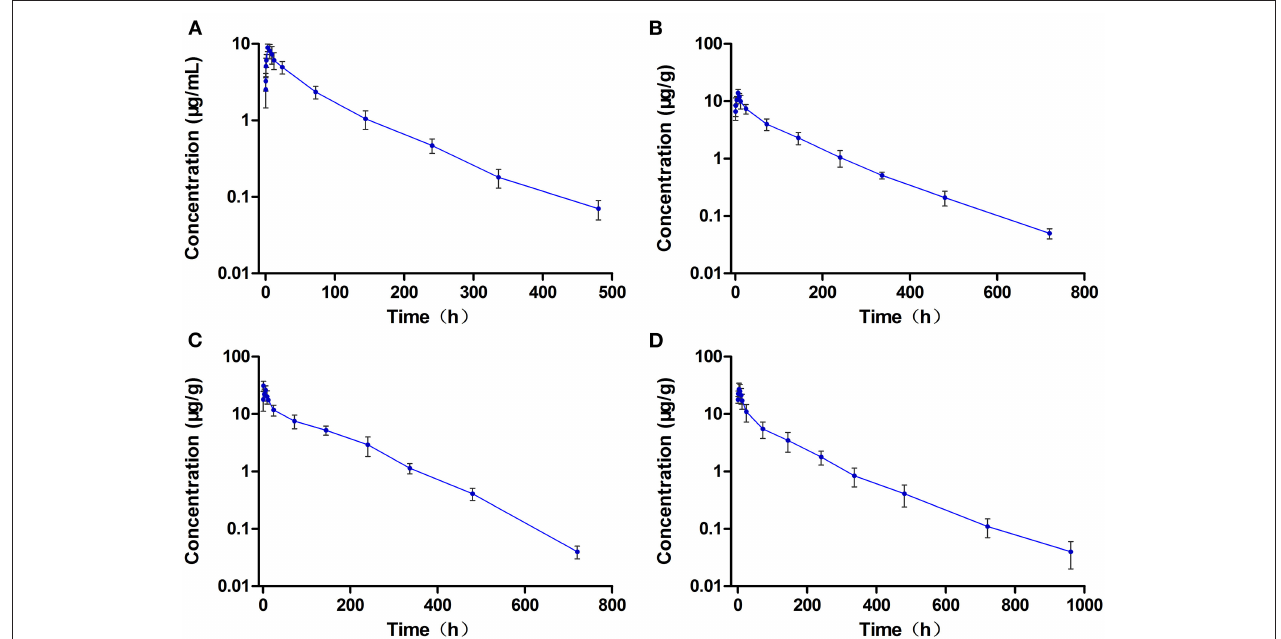
FIGURE 2 | The concentration vs. time curves of enrofloxacin in the plasma (A) , muscle/skin (B) , liver (C) , and kidney (D) of crucian carp after a single oral dose of enrofloxacin (20 mg/kg b.w.) at 28 ◦ C ( n = 6).